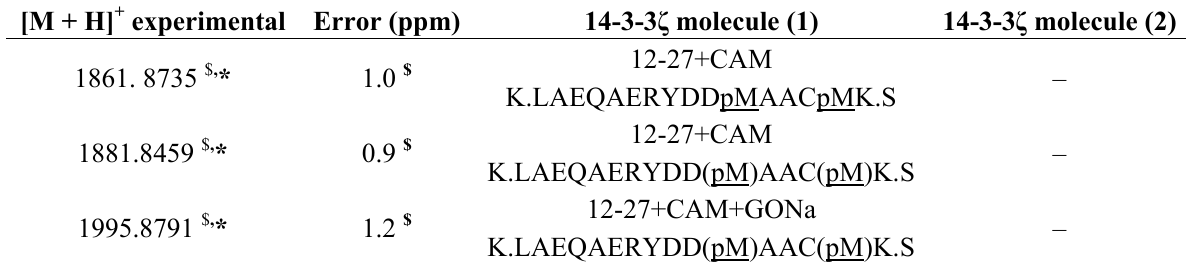
Table 3. Photo-initiated cross-linked products (potentially intramolecular or modified) identified in 14-3-3 ζ monomer (molecule 1) by * MALDI-FTICR or $ LC-FTICR MS. [M + H] + experimental Error (ppm) 1861. 8735 $ , * K.LAEQAERYDDpMAACpMK.S